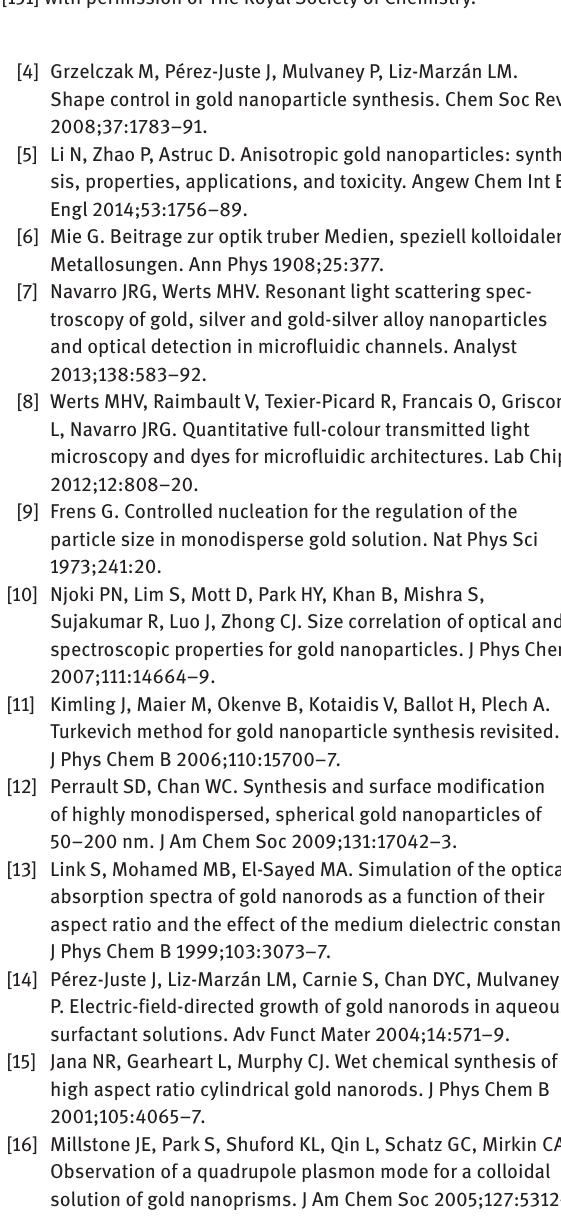
Figure 24: Left: Extinction spectra of CTAB-protected AuBPs (full line) and Lucifer yellow polymer functionalized PEGylated AuBPs (dotted line). Right: Fluorescence spectra of the LY-PNAM-PEG-Au-BP nanoparticles before (full line) and after (dotted line) dissolution of the gold core with the addition of the cyanide solution (12 h). Adapted from Ref. [151] with permission of The Royal Society of